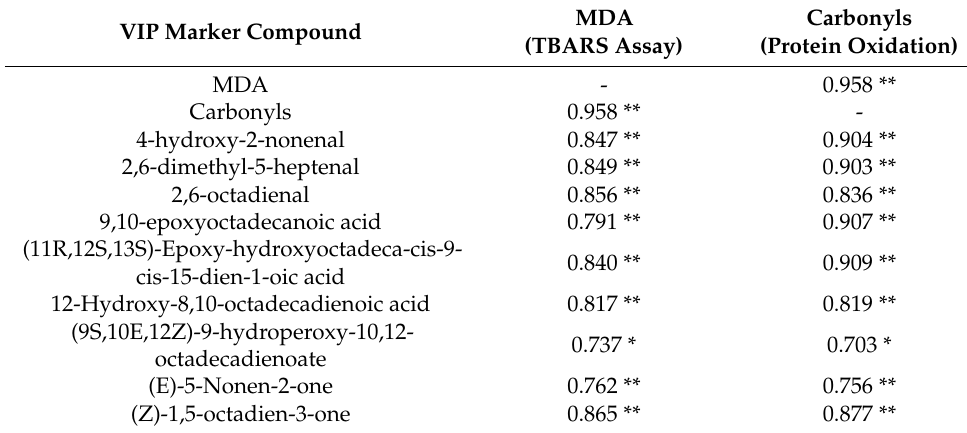
Table 3. Pearson’s correlation coefficients considering malonaldehyde (MDA), total carbonyl content, and VIP discriminant metabolites related to lipid and protein oxidation reactions, as highlighted by OPLS-DA supervised model. MDA VIP Marker Compound (TBARS